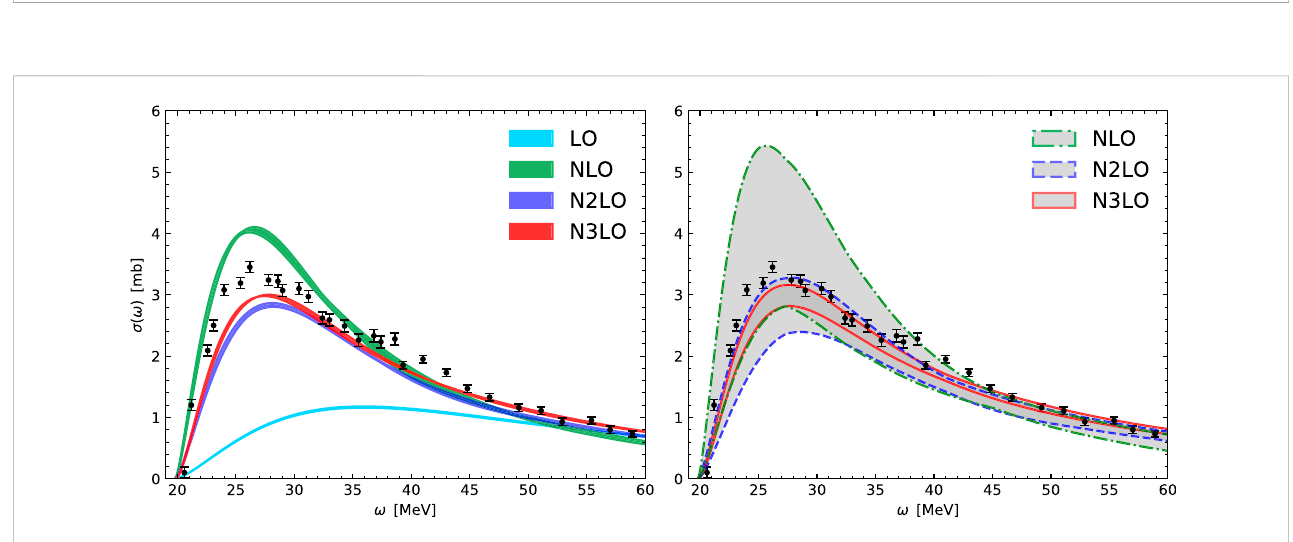
FIGURE 4 Inclusive 4 He photoabsorption cross section calculated at different order in the chiral interaction. Left panel: bands display the numerical uncertainty in the inversion of the LIT. Right panel: bands display the χ EFT truncation uncertainty, estimated using Eq. 6. The experimental data are taken from Ref. [61].